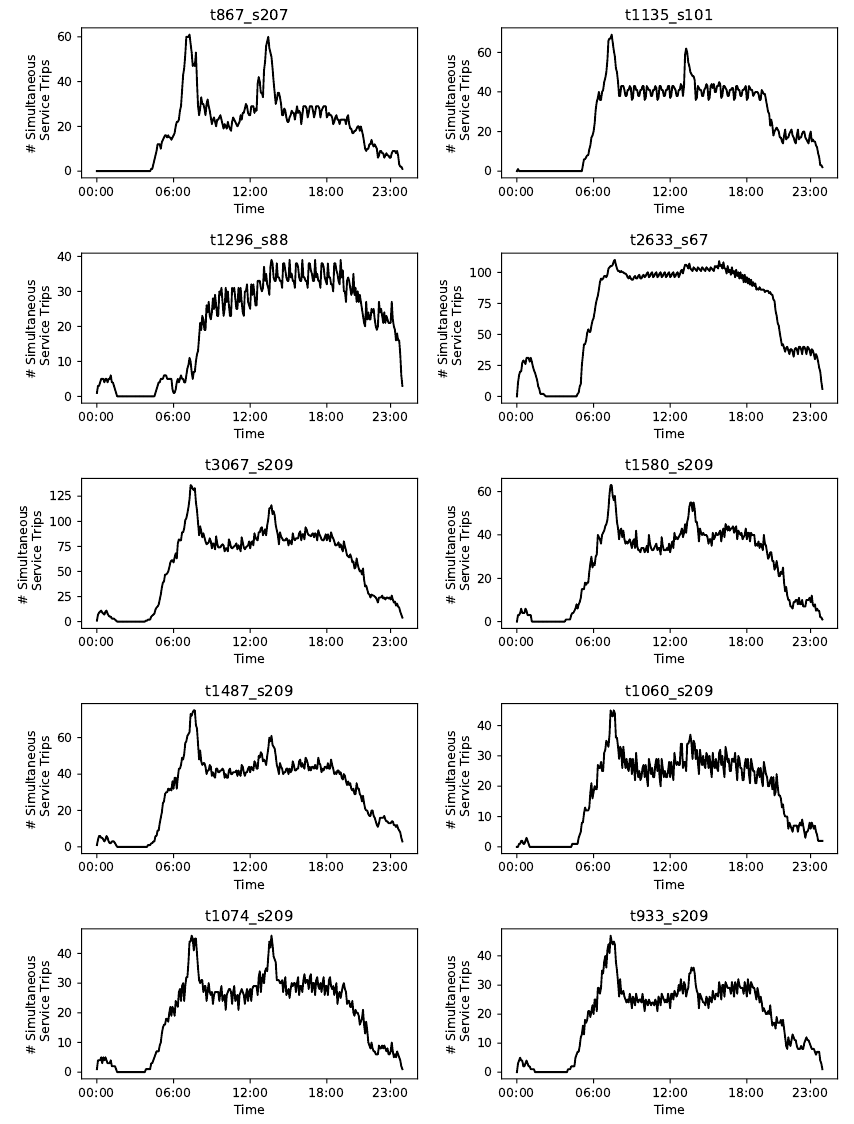
Figure 2. Profiles of cumulative service